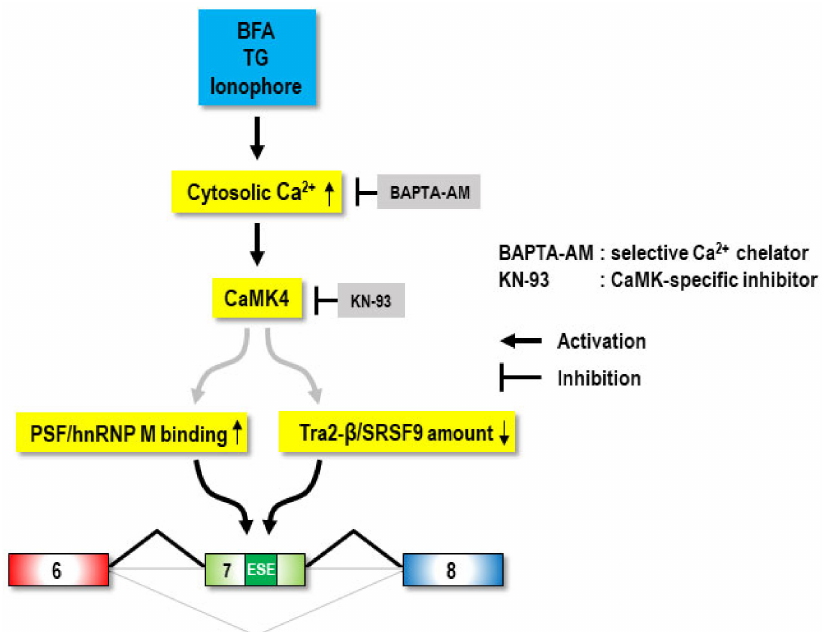
Figure 7. Expected pathway of calcium-mediated SMN splicing regulation. BFA, thapsigargin (TG) and calcium ionophore commonly increase the cytosolic calcium concentration, which is critical for the rescue of the SMN2 exon 7 splicing defect. In this pathway, CaMK4 may relay the stim- ulatory signal of the calcium to splicing factors, such as hnRNP M, PSF, Tra2- β and hnRNP A1, and consequently promote exon 7 inclusion in SMN splicing (black fold in the bottom). Thin and short arrows (upward and downward) indicate the increase or the decrease of RNA-binding or protein amount of trans-acting factors. The numbers (6, 7, and 8) indicate exon 6, 7, and 8 of SMN2 pre-mRNA,